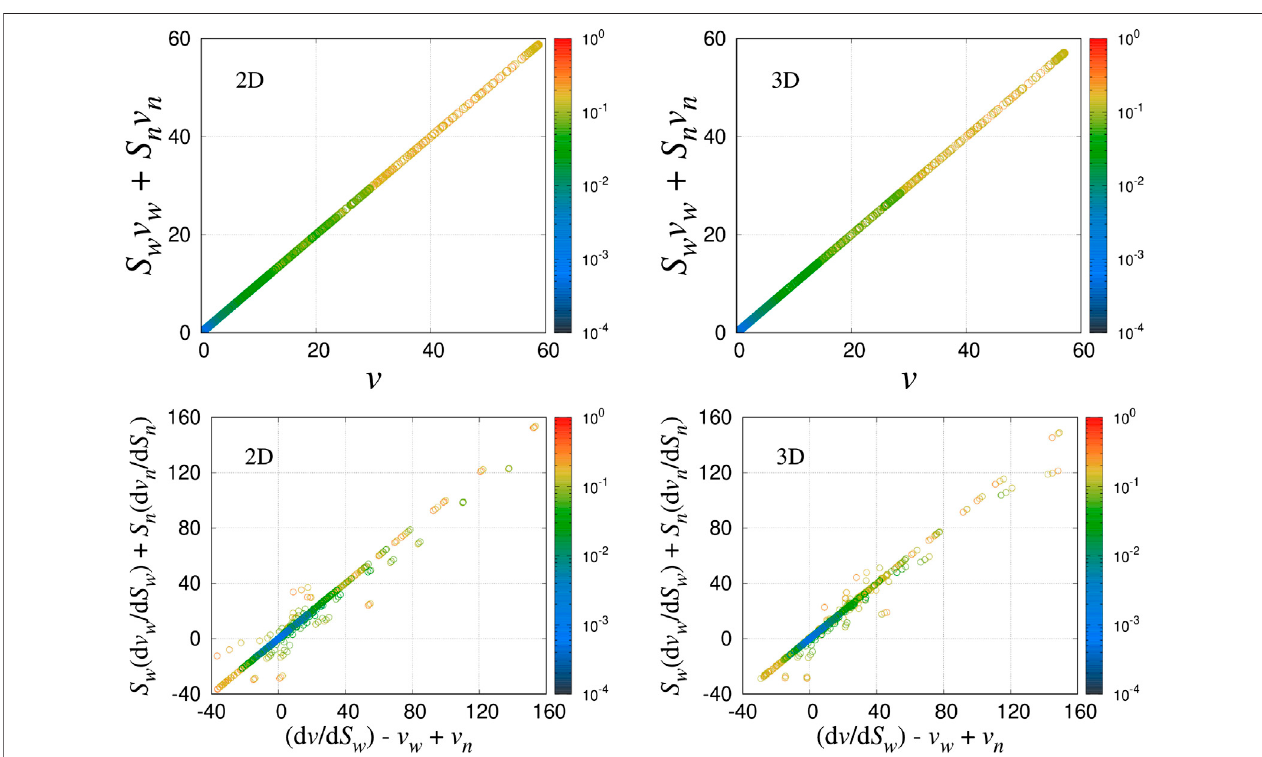
FIGURE13| Plotsof S w v w + S n v n againstthetotalseepagevelocity v for2Dand3Dareshowninthetop.The fl owratesandporeareastocalculate v w , v n and v are measuredusing Eqs.17 , 18 for2Dandusing 19 and 20 for3D.Thevelocitiesareintheunitofmm / s.Thecolorsrepresentthecapillarynumberswhichareintherangeof 0 . 0007 − 0 . 2985for2Dand0 . 001 − 0 . 271for3D.Themeasurementsshowtheexactmatchof Eq.16